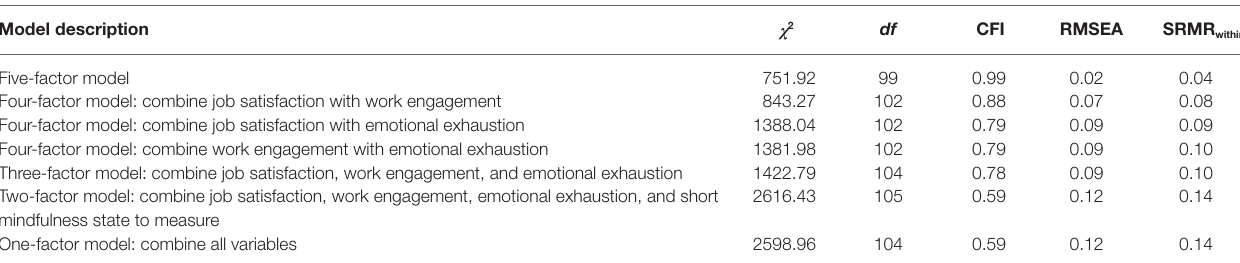
TABLE 2 | Discriminant validity of study variables: multilevel confirmatory factor analyses. Model